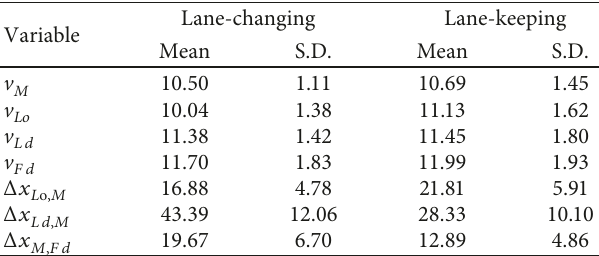
Table 1: Descriptive statistics of samples.